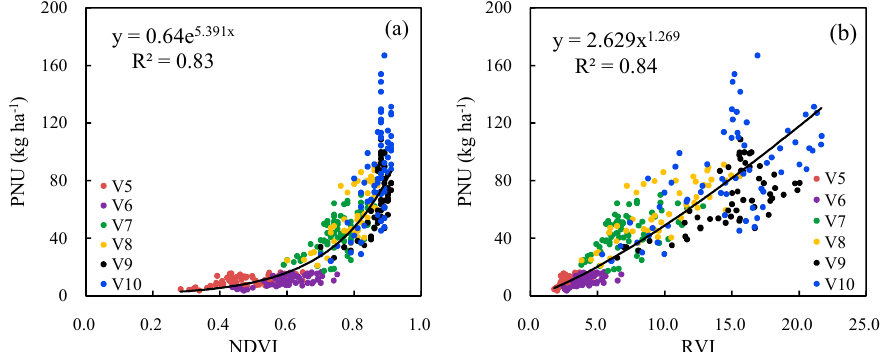
Figure 9. Relationships between plant N uptake (PNU) and GreenSeeker sensor-based normalized difference vegetation index (NDVI) ( a ) or ratio vegetation index (RVI) ( b ) across V5 to V10 growth stages.